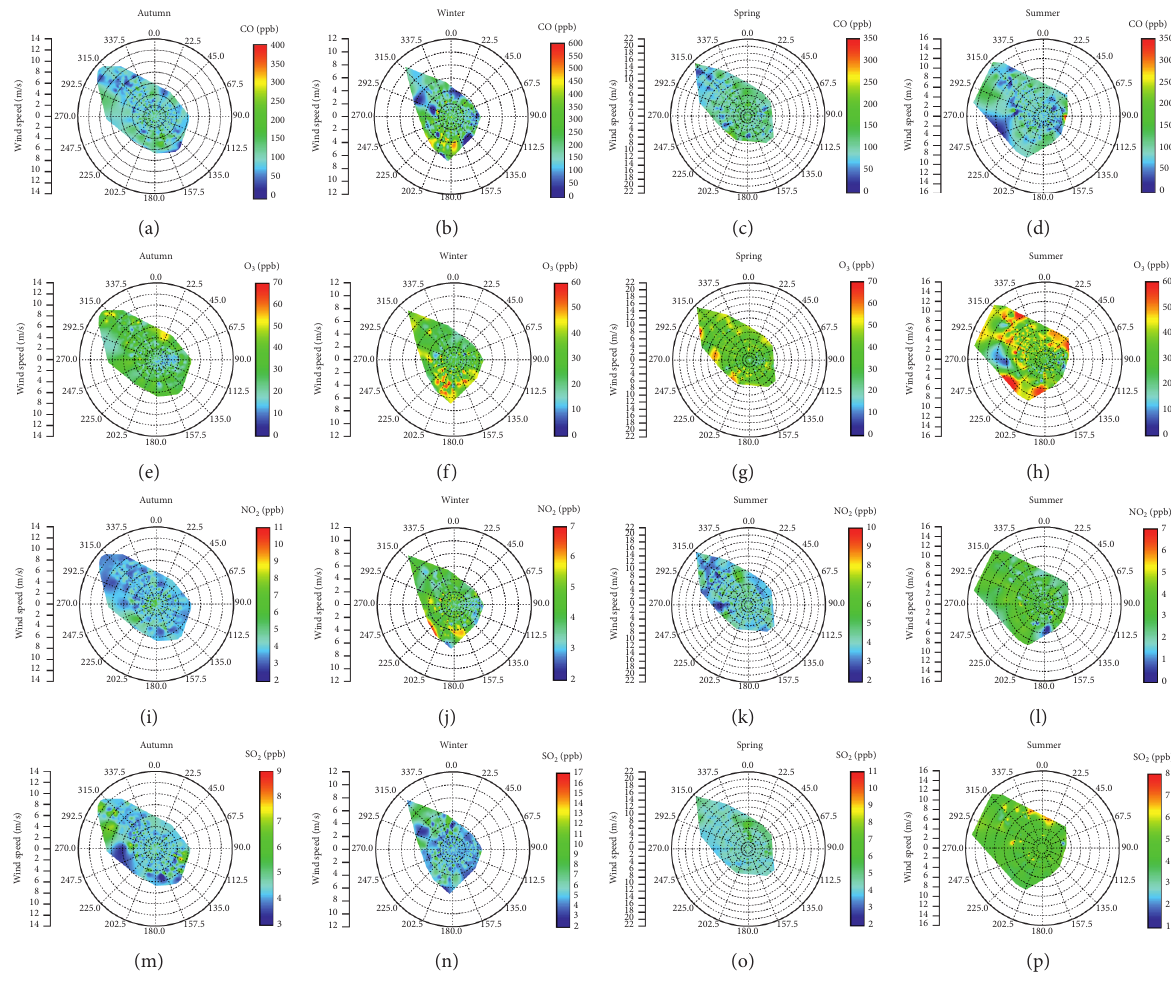
Figure 5: Wind roses with reactive gases (CO, O